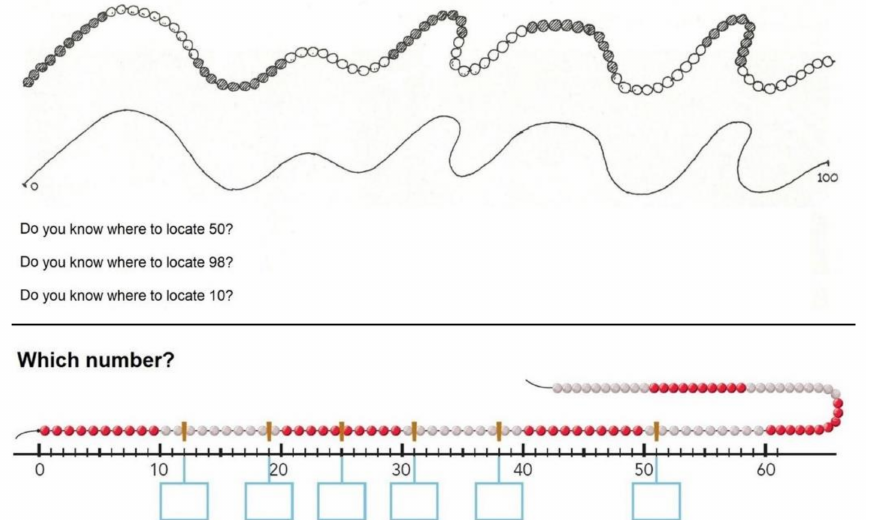
Figure 11. The number bead combined with the empty number line in PP1 (1990s, above, Grade 2, lesson book p. 57) and with the segmented number line in WiG5 (2019, below, Grade 1, student book 8, p. 4 [Reprinted with permission of Malmberg Publishers]).